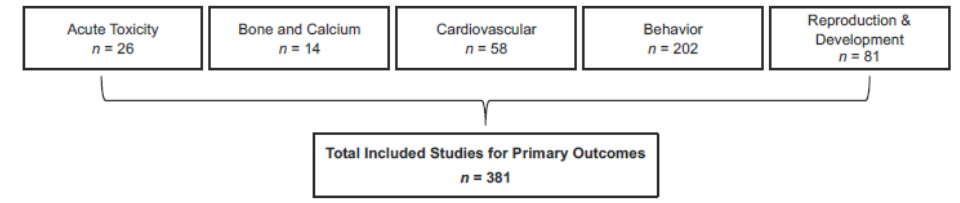
Figure 4. Number of studies that met the SR inclusion criteria and were reviewed for each endpoint.